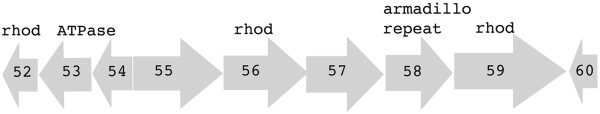
Cluster of unique genes in Gplasma. Arrows are proportional to the length of each gene and indicate its direction of transcription. The gene numbers are shown inside the arrows. All genes are from contig number 13327. Motif and domain-based annotations are shown above the arrows. Genes with no annotations are hypothetical proteins. Rhod indicates a rhodanese-like domain.